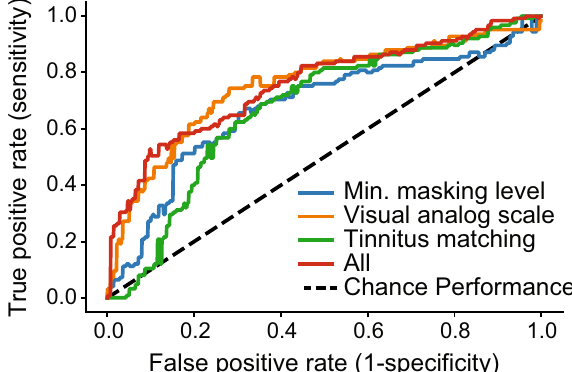
Fig. 2 Receiver operator characteristic linear regression on tinnitus psychoacoustic task outcomes. Combining the outcomes across MML, VAS, and Matching tasks achieved a 66% Accuracy and an AUC =